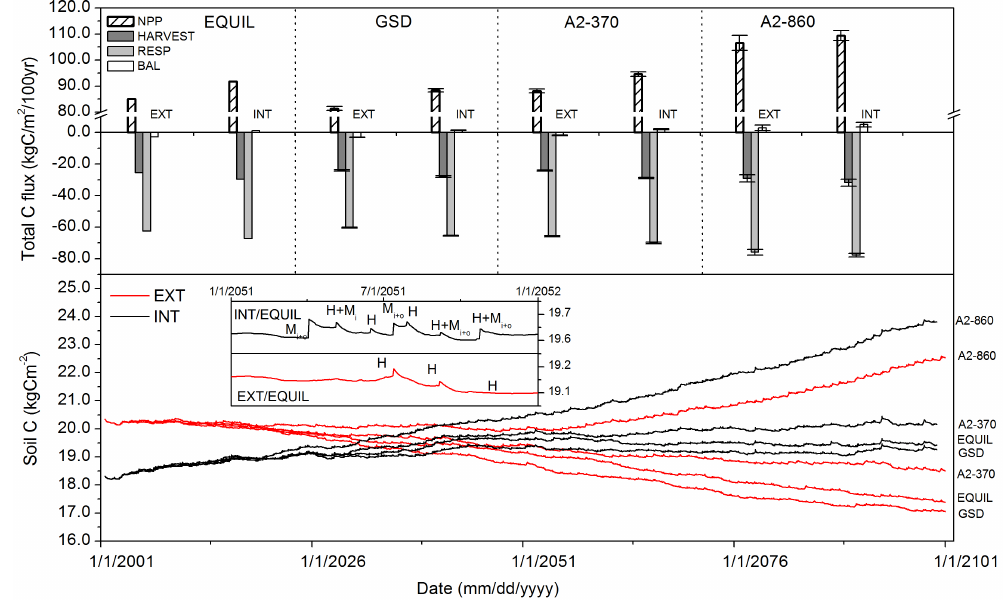
Fig. 5. Simulations of soil organic C (in gCm − 2 ) between 2001–2100. Top panel: C budget 100 years after establishment of grassland. Bottom panel: Temporal C dynamics between 2001–2100 (inset: simulations of SOC between 2051–2052 for INT and EXT. Management activities are shown as H = harvest; M i and M i + o = inorganic and organic plus inorganic manure application, respectively). Legend entries: NPP = Net Primary Productivity, Harvest = extracted biomass, Resp = heterotrophic respiration, Bal = C balance